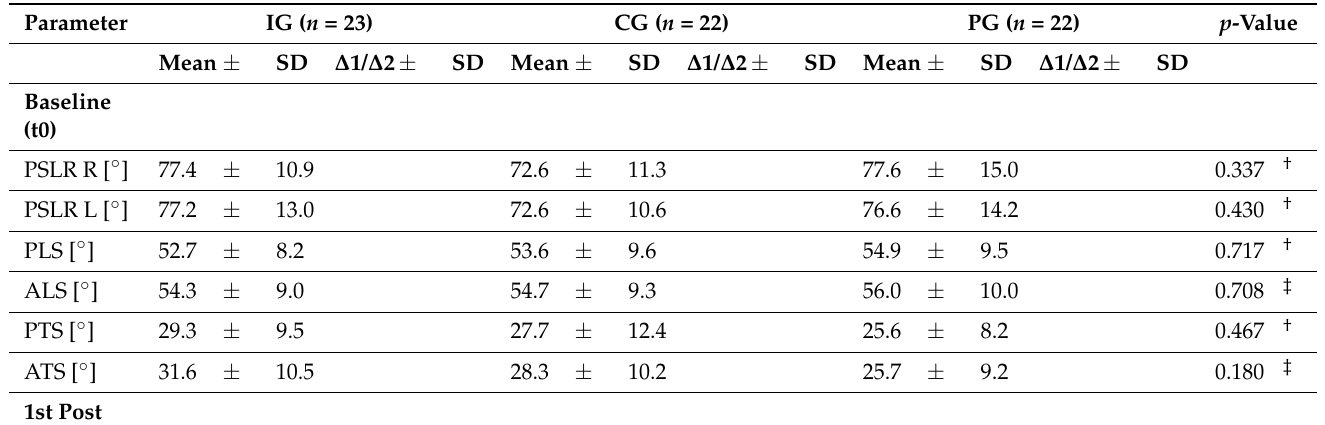
Table 3. Functional Movement